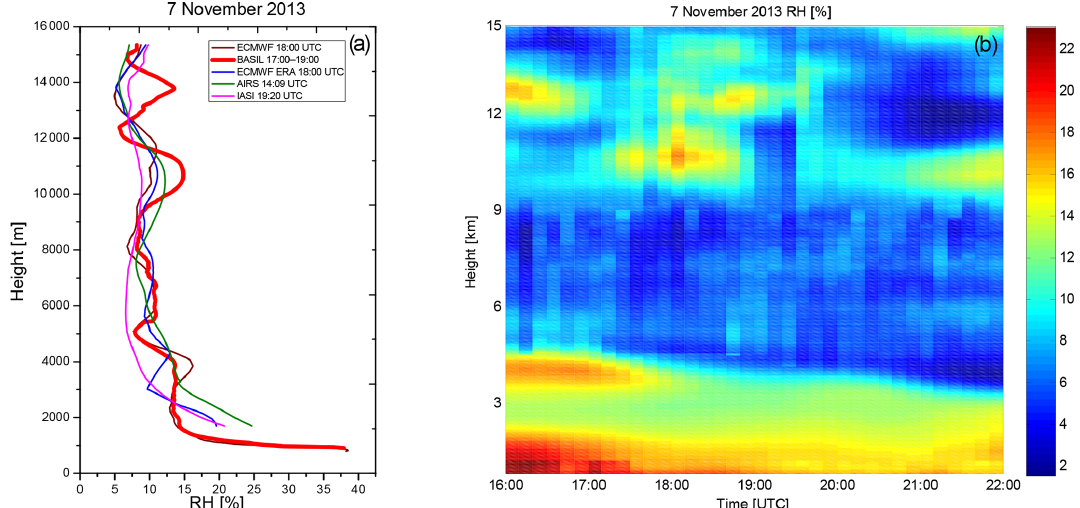
Figure 5. Vertical profile of relative humidity as measured by BASIL over the time period from 17:00 to 19:00UTC on 7 November 2013 and the closest profiles (in time) from IASI (at 19:20UTC), AIRS (at 14:09UTC) and the ECMWF (ERA-15 and ERA-40, at 18:00UTC) model reanalysis (b) . Time evolution of the relative humidity profile as measured by BASIL over the interval from 18:00 to 22:00UTC on 7 November 2013 (a)